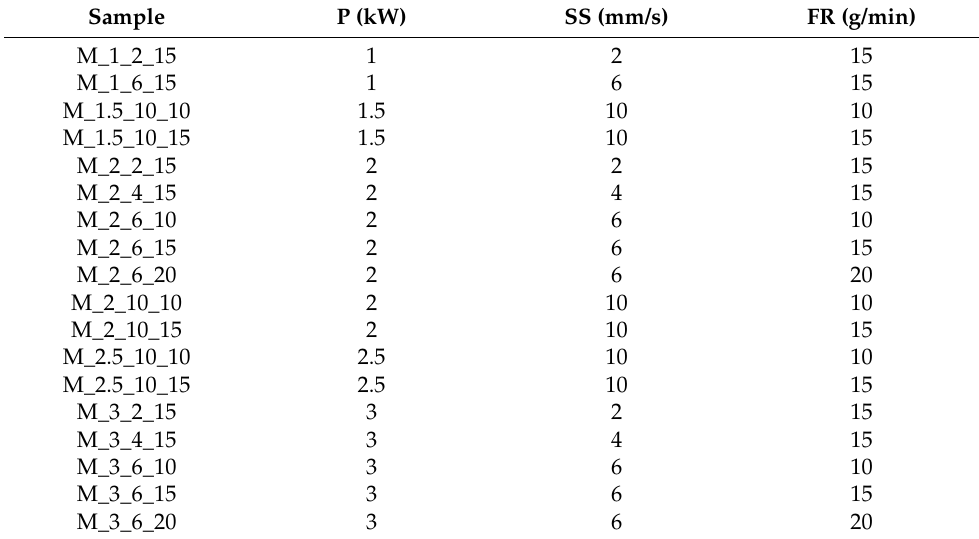
Table 2. Samples and parameters used to optimize the DLD